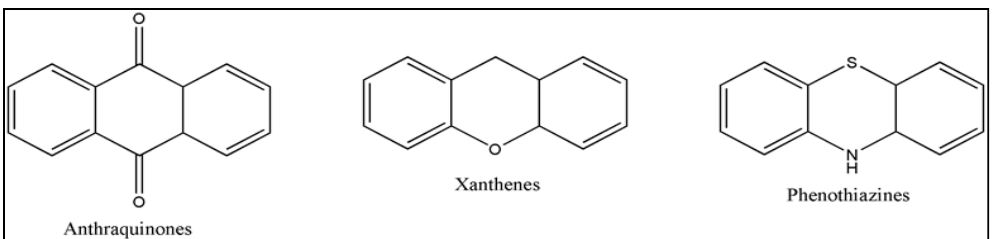
Figure 3. Examples of nonporphyrin: Anthraquinones, Xanthenes, Phenothiazines.